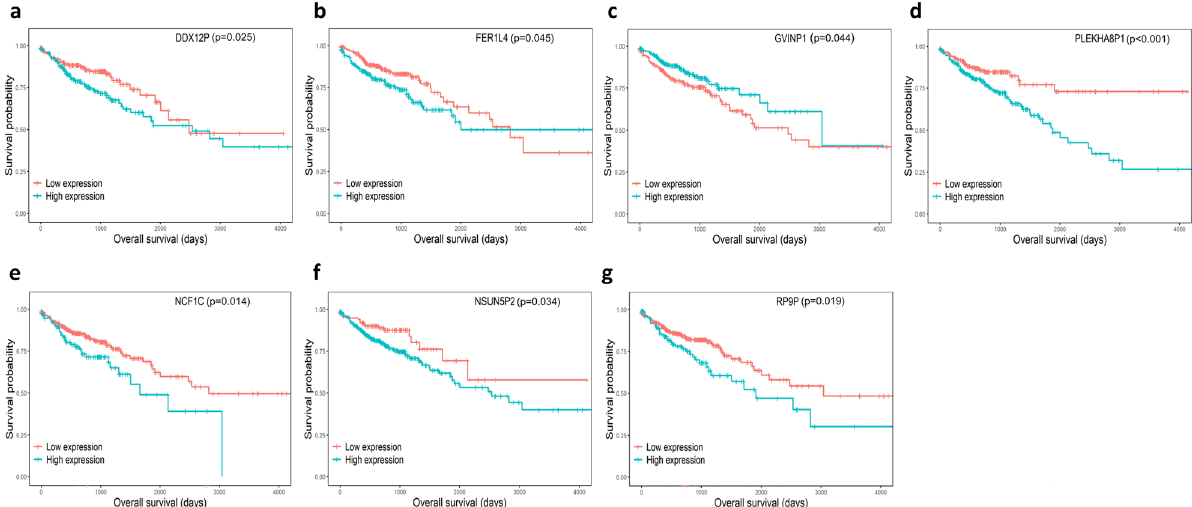
Figure 3. Kaplan–Meier curve analysis of DE pseudogenes in the ceRNA network. Seven pseudogenes were found to be significantly related to overall survival with p < 0.05. ( a ) DDX12P, ( b ) FER1L4, ( c ) GVINP1, ( d ) PLEKHA8P1, ( e ) NCF1C, ( f ) NSUN5P2, ( g )